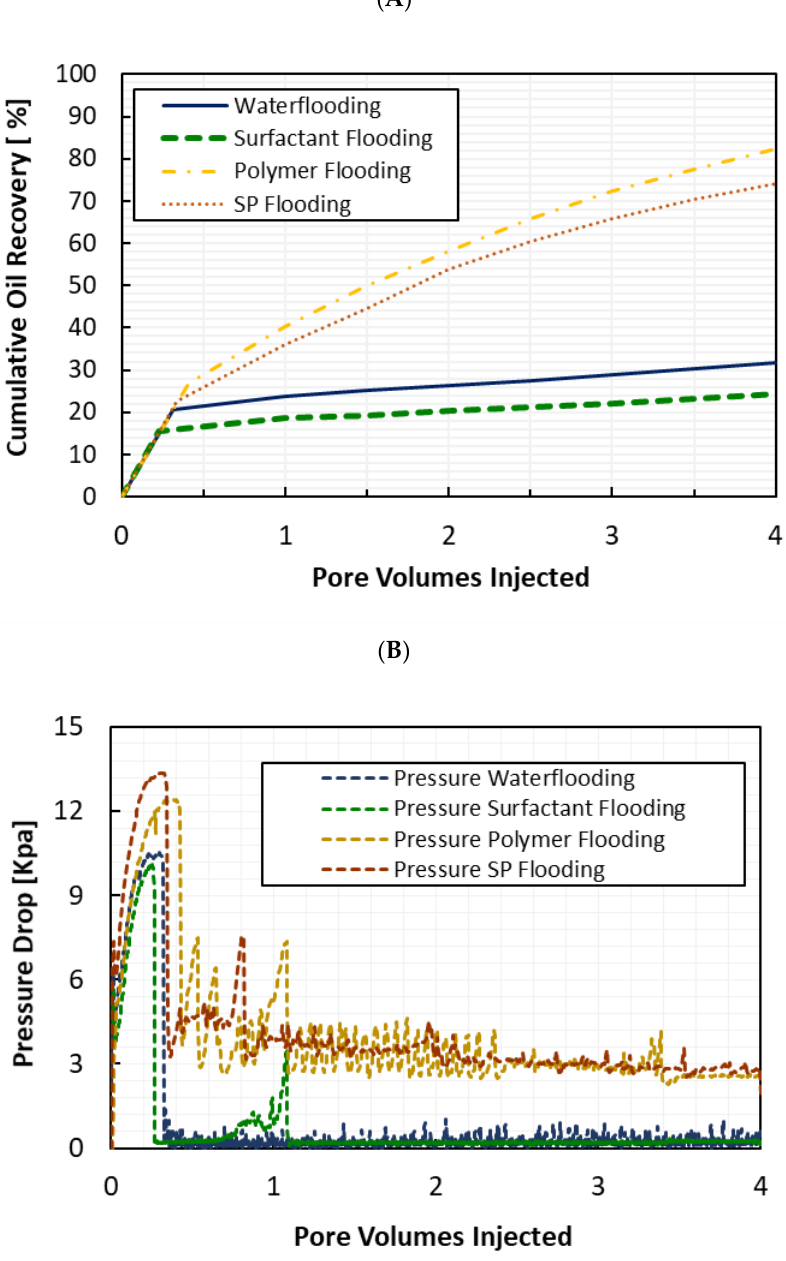
Figure 14. Cumulative oil recovery ( A ) and pressure drop ( B ) in different chemical solutions at 0.3 mL/min in crude oil displacements.